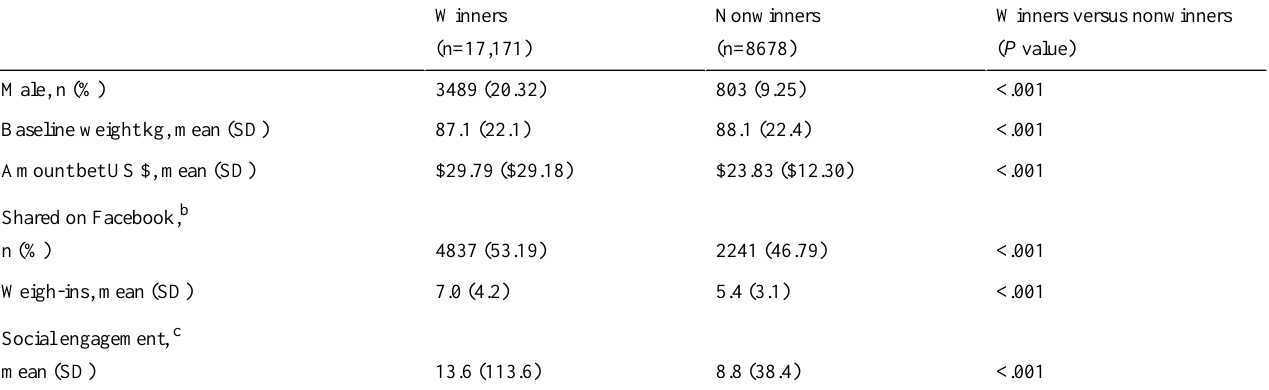
Table 2. Winners’versus nonwinners’baseline characteristics and engagement. a